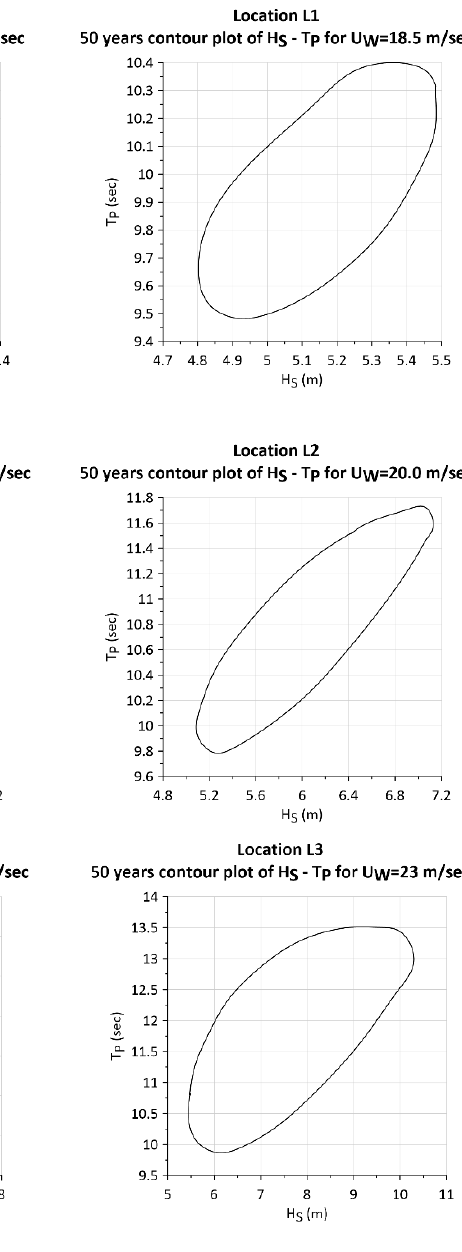
Figure 4. The 50-year contour surfaces of significant wave height and spectral peak period for different values of wind speed for location L1 ( upper row ), L2 ( middle row ) and L3 ( lower row ).